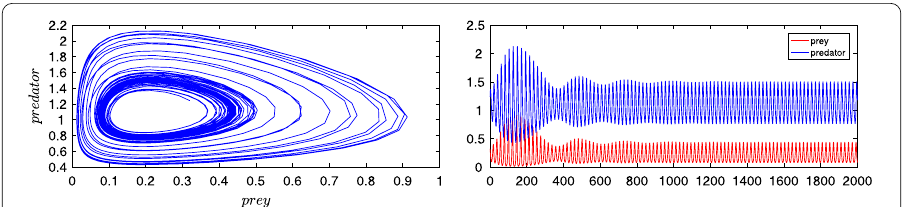
Figure 2 The two figures show that the coexistence equilibrium E 2 is unstable with parameter values ε = 1, κ = 2, μ = 0.17, d = 0.0125, m = 0.02, τ 1 = 2, τ 2 = 2. System (2.2) has a periodic solution. Left panel: the phase graph of model (2.2) in each patch; right panel: the trajectory graph of model (2.2) in each patch